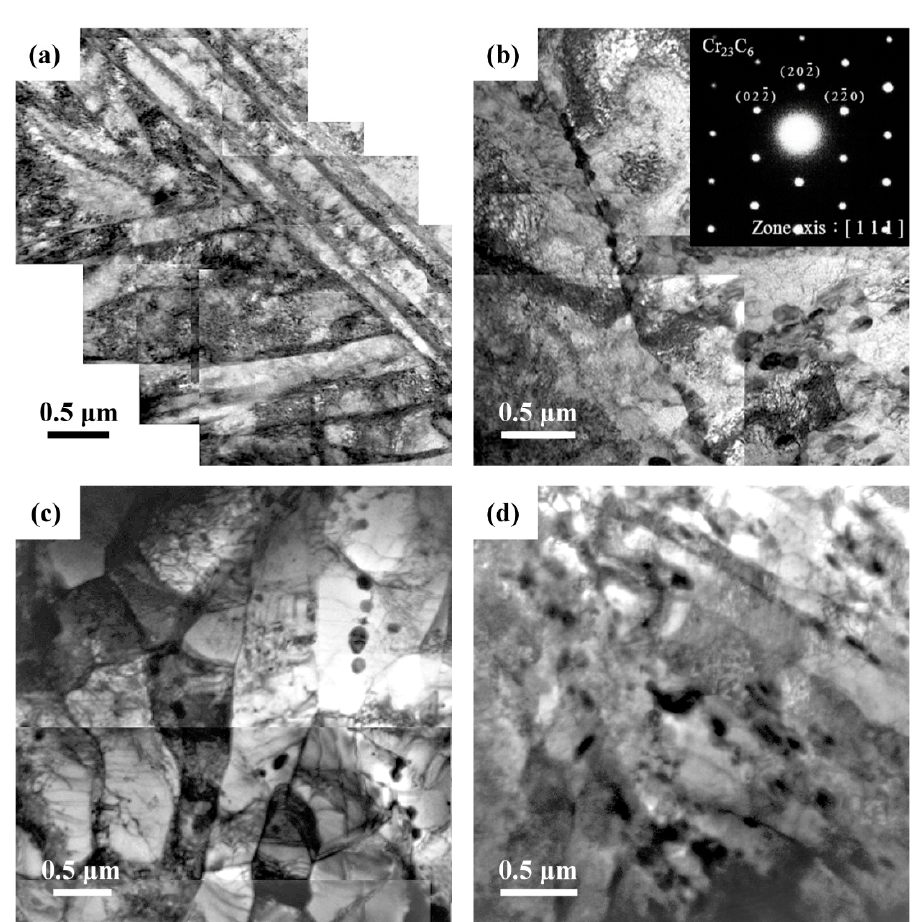
Figure 4. TEM micrographs of the ( a ) W, ( b ) WT, ( c ) WT ‐ 820T and ( d ) WT ‐ 890T samples.